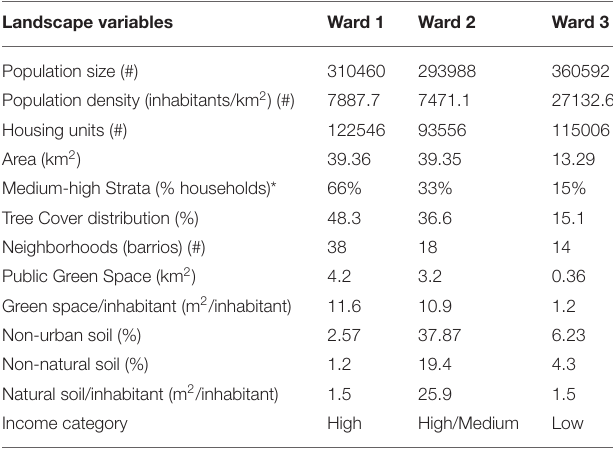
TABLE 1 | Socio-demographic and landscape cover traits for the three wards of the Santo Domingo’s National District as reported by official sources [Villalona and Alfonso, 2006; Oficina Nacional de Estadísticas (ONE), 2010; Alcaldía del Distrito Nacional, 2019; Programa de la Naciones Unidas para el Desarrollo (PUND),